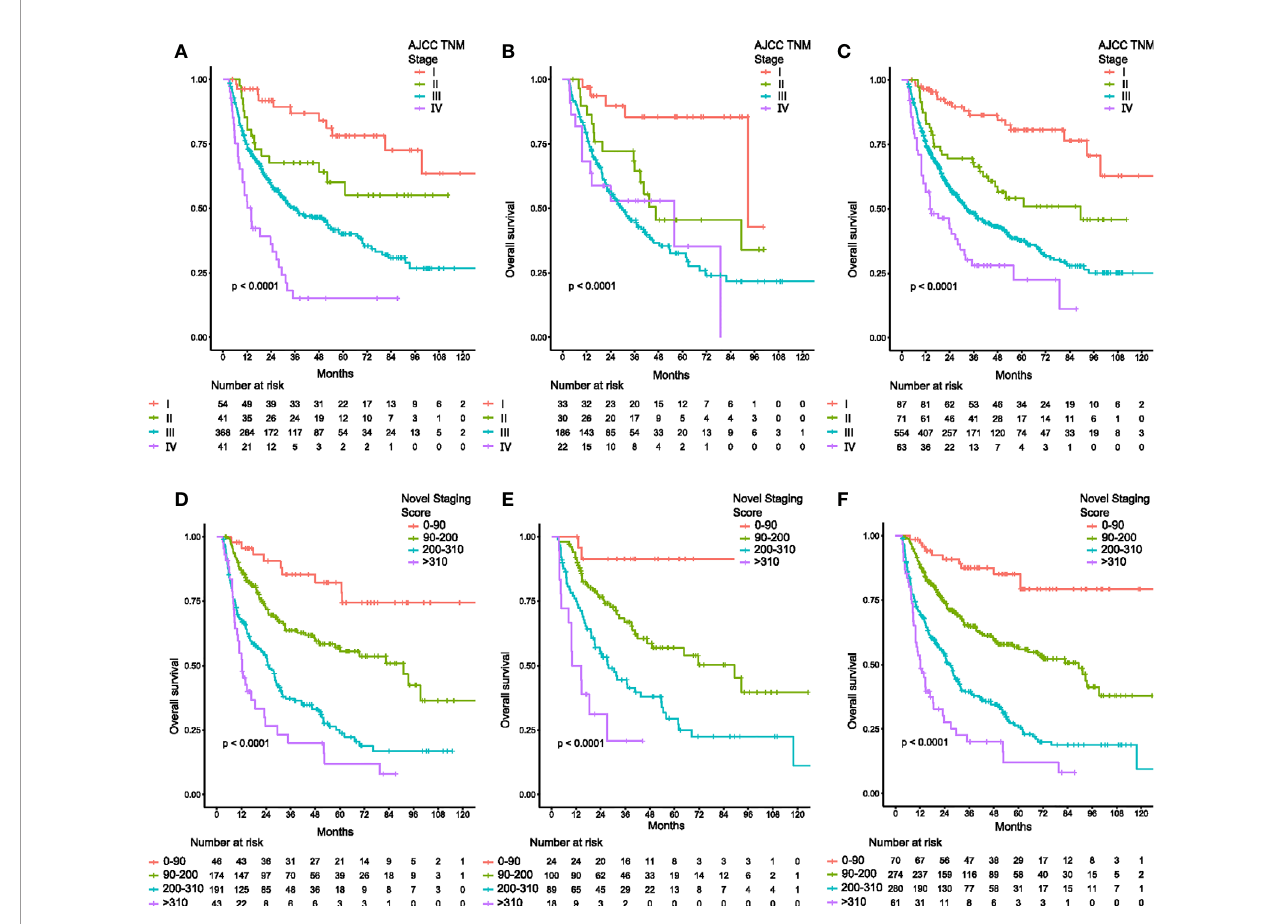
FIGURE 3 | Kaplan-Meier curves of overall survival for patients classi fi ed by TNM staging system and the novel staging system. (A) discovery cohort classi fi ed by TNM system, (B) validation cohort classi fi ed by TNM system, (C) total cohort classi fi ed by TNM system, and (D) discovery cohort classi fi ed by the novel staging system, (E) validation cohort classi fi ed by the novel staging system, (F) total cohort classi fi ed by the novel staging